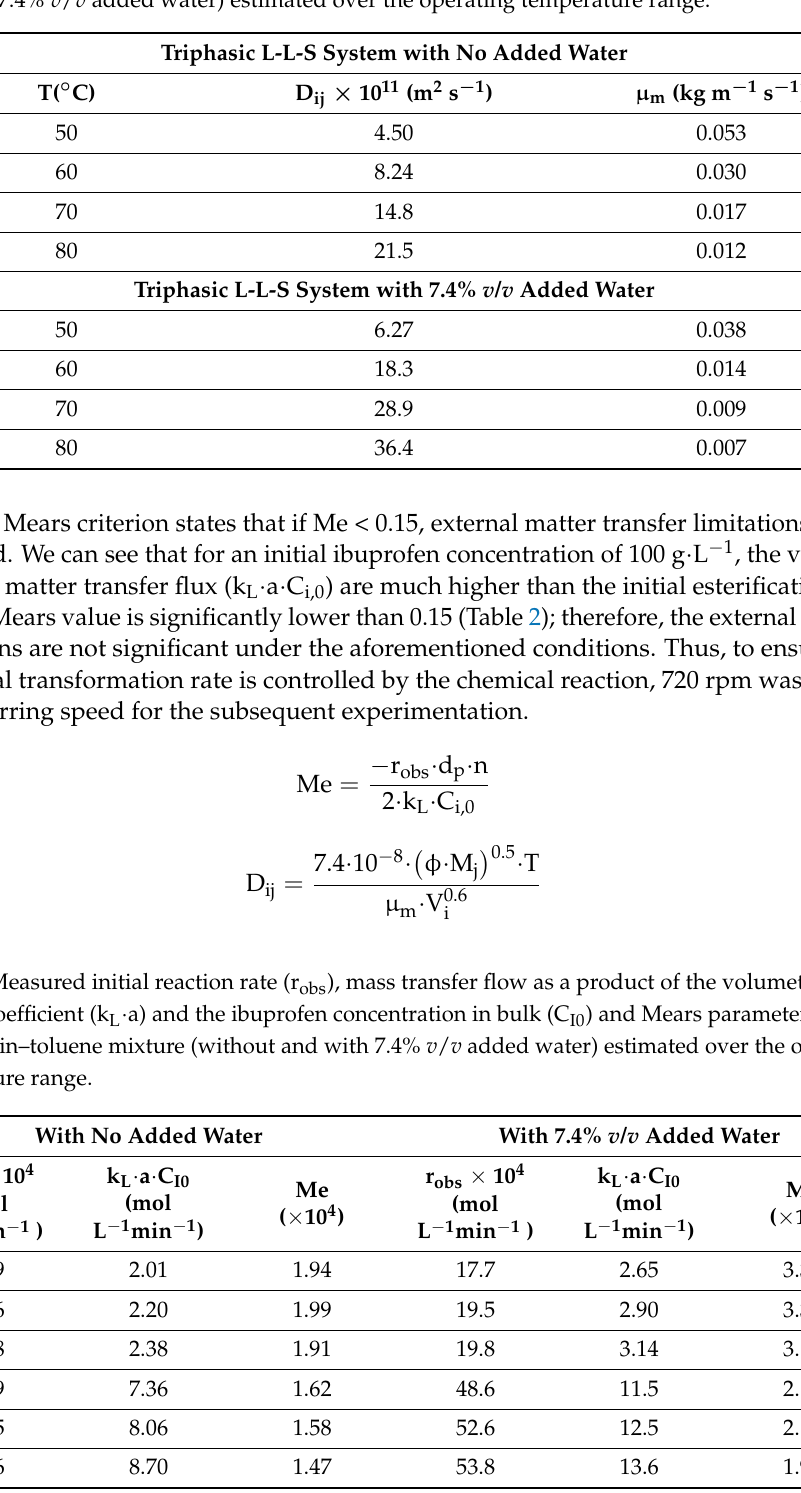
Table 1. Molecular diffusivity (D ij ) and viscosity ( µ m ) values of the glycerin–toluene mixture (without and with 7.4% v / v added water) estimated over the operating temperature range.